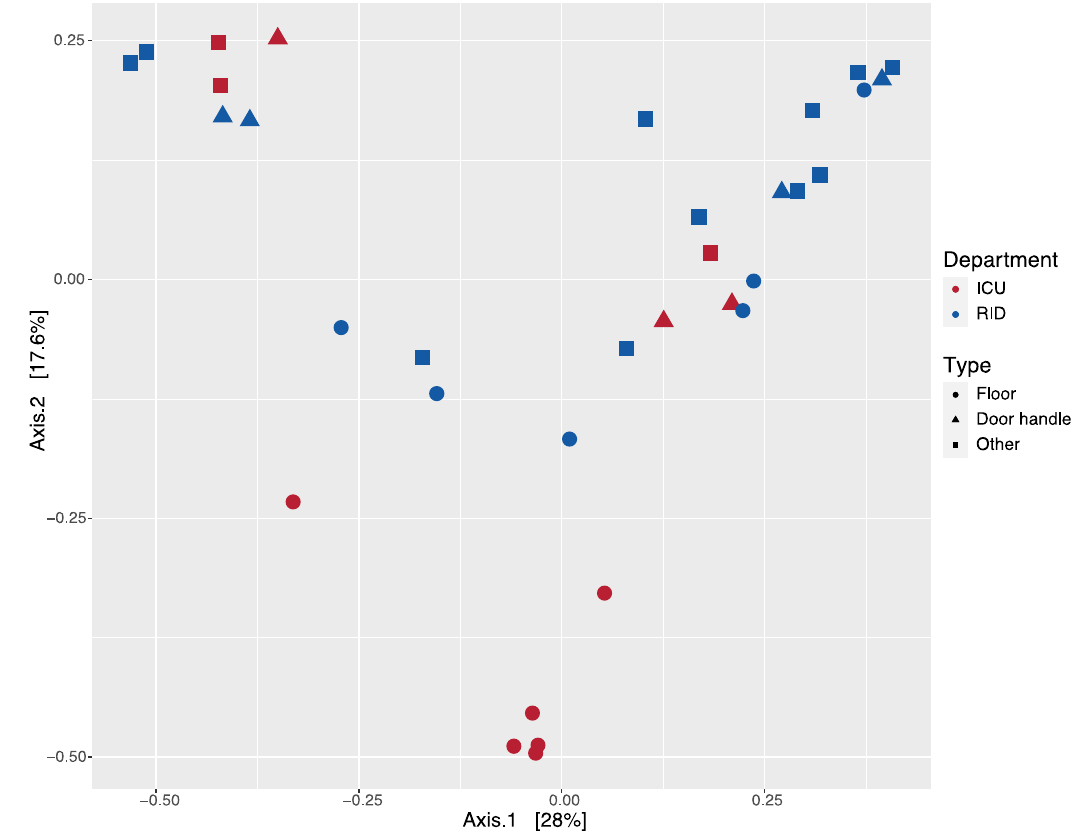
Figure 3. Bray–Curtis dissimilarity PCoA was used to generate ordination of beta-diversity in two departments. Principal coordinates 1 and 2 (Axis.1 and Axis.2) explained 28% and 17.6% of the variance in Bray–Curtis dissimilarity, respectively. Samples are colored according to the department (ICU—Intensive Care Unit; RID—Respiratory Infections Department), symbols indicate the type of sample.